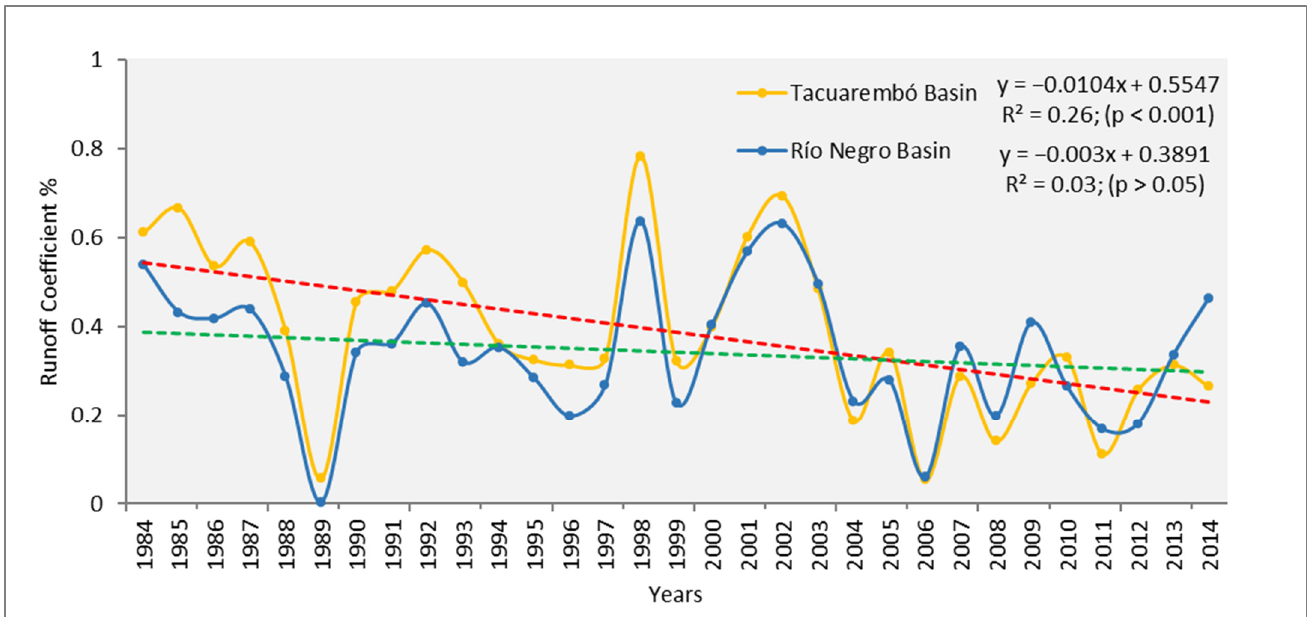
Figure 10. Trend analysis and level of significance of the surface runoff coefficient in the Tacuarembó basin (yellow line) and Río Negro basin (blue line). The broken red and green lines correspond to the trend of the runoff coefficient time series of the Tacuarembó and Rio Negro basins, respectively.